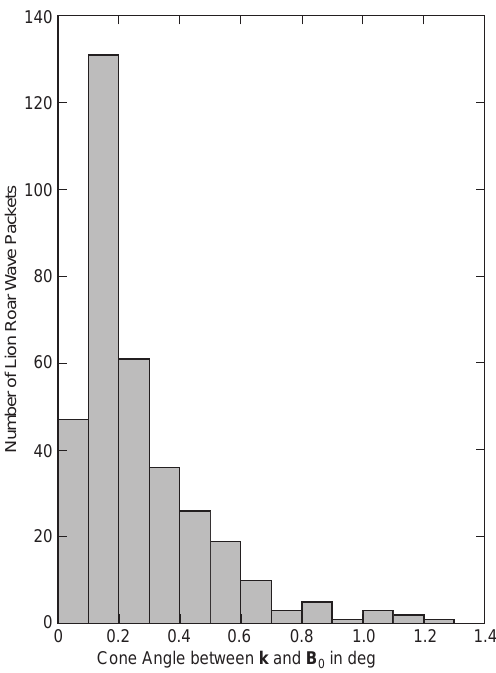
Fig. 6. Occurrence distribution between lion roar wave vector and ambient magnetic field. Ten more cases (between 1.5 (cid:14) and 5 (cid:14) ) have been omitted from this